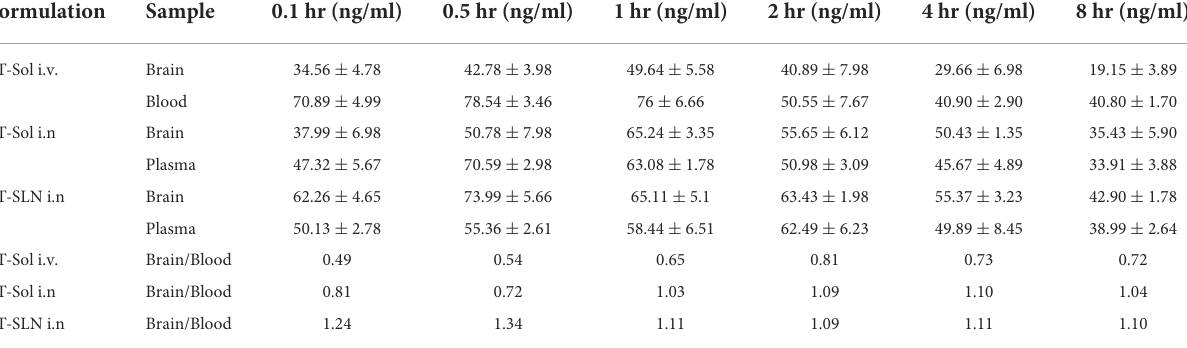
TABLE 4 Compartmental distribution of RT-SLN (i.n.) and RT solution after i.n. and i.v. administration ( n = 3 ± S.D).